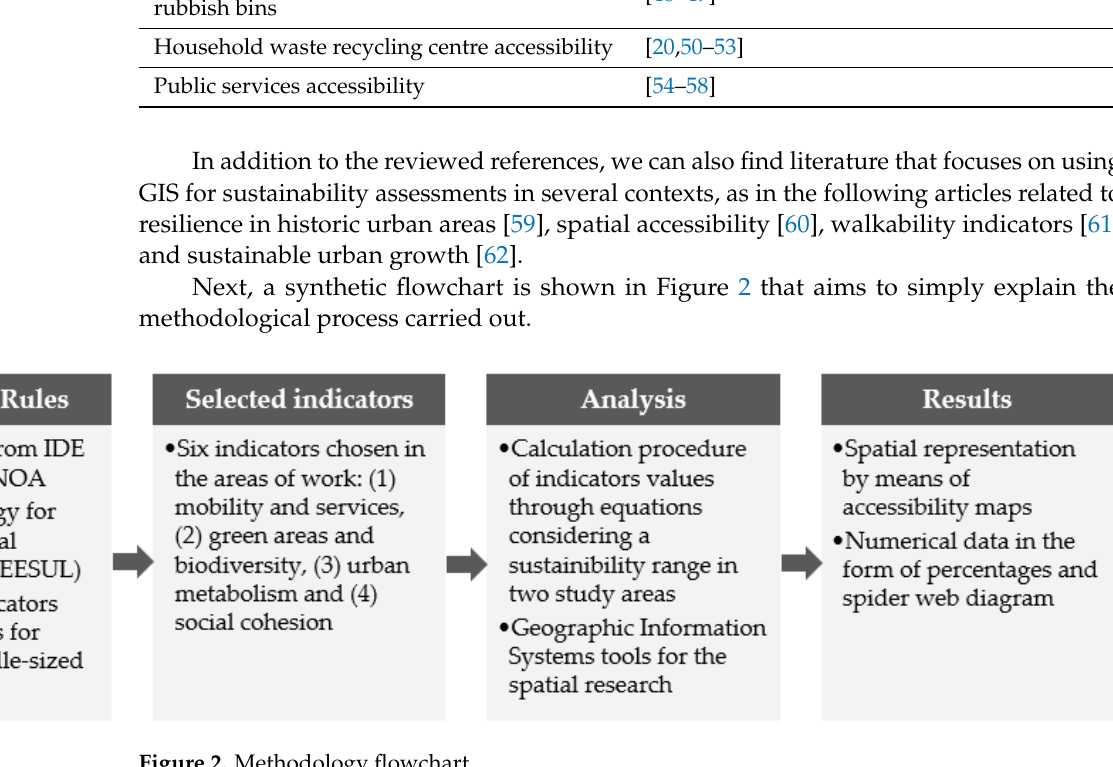
Figure 2. Methodology flowchart.